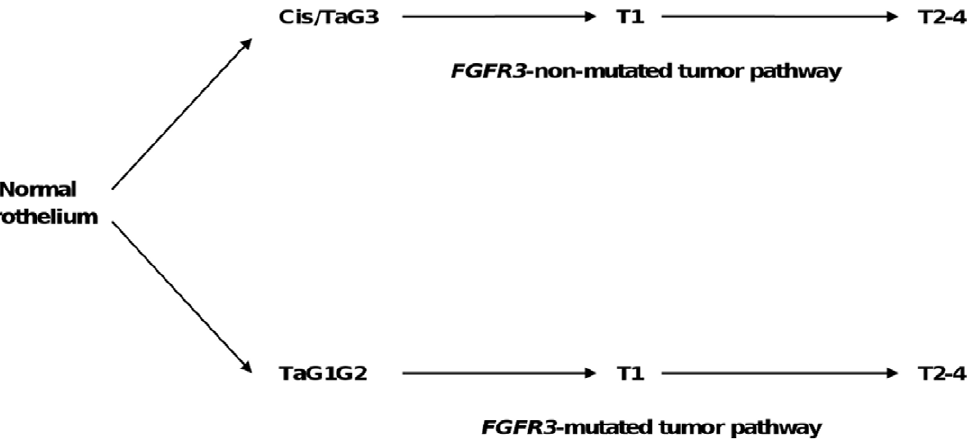
Figure 5. Model of bladder cancer. The ‘‘FGFR3 model’’ of bladder cancer progression distinguishes a FGFR3 -non-mutated tumor pathway and a FGFR3- mutated tumor pathway. Cis: Carcinoma in situ . Stages were defined by the 1997 TNM classification and grades by the 1973 World Health Organization classification (see Material and Methods for reference).